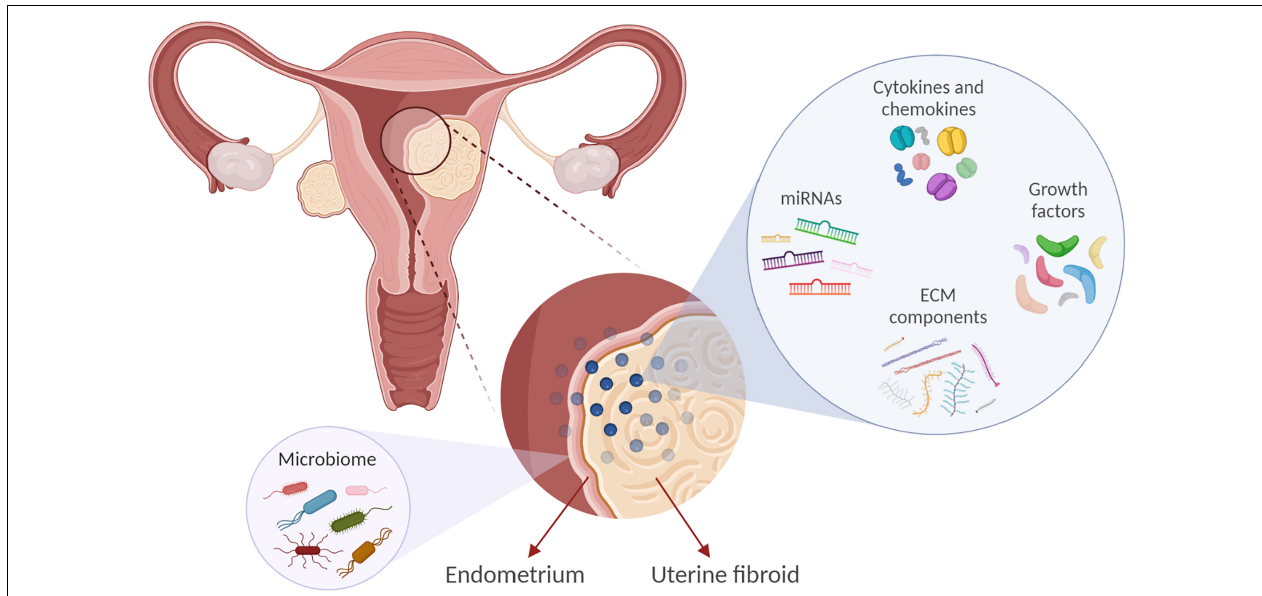
FIGURE 1 | Factors implicated in uterine fibroid (UF) development and growth may influence the endometrial biology. Extracellular matrix (ECM) components, microRNAs (miRNAs), growth factors, cytokines, and chemokines are involved in UF development. These factors may also affect endometrial cell growth and function and vessel remodeling, thereby contributing to the increased incidence of reproductive complications such as heavy and irregular menses and infertility. In addition, we propose that UFs may impact the endometrial microbiome